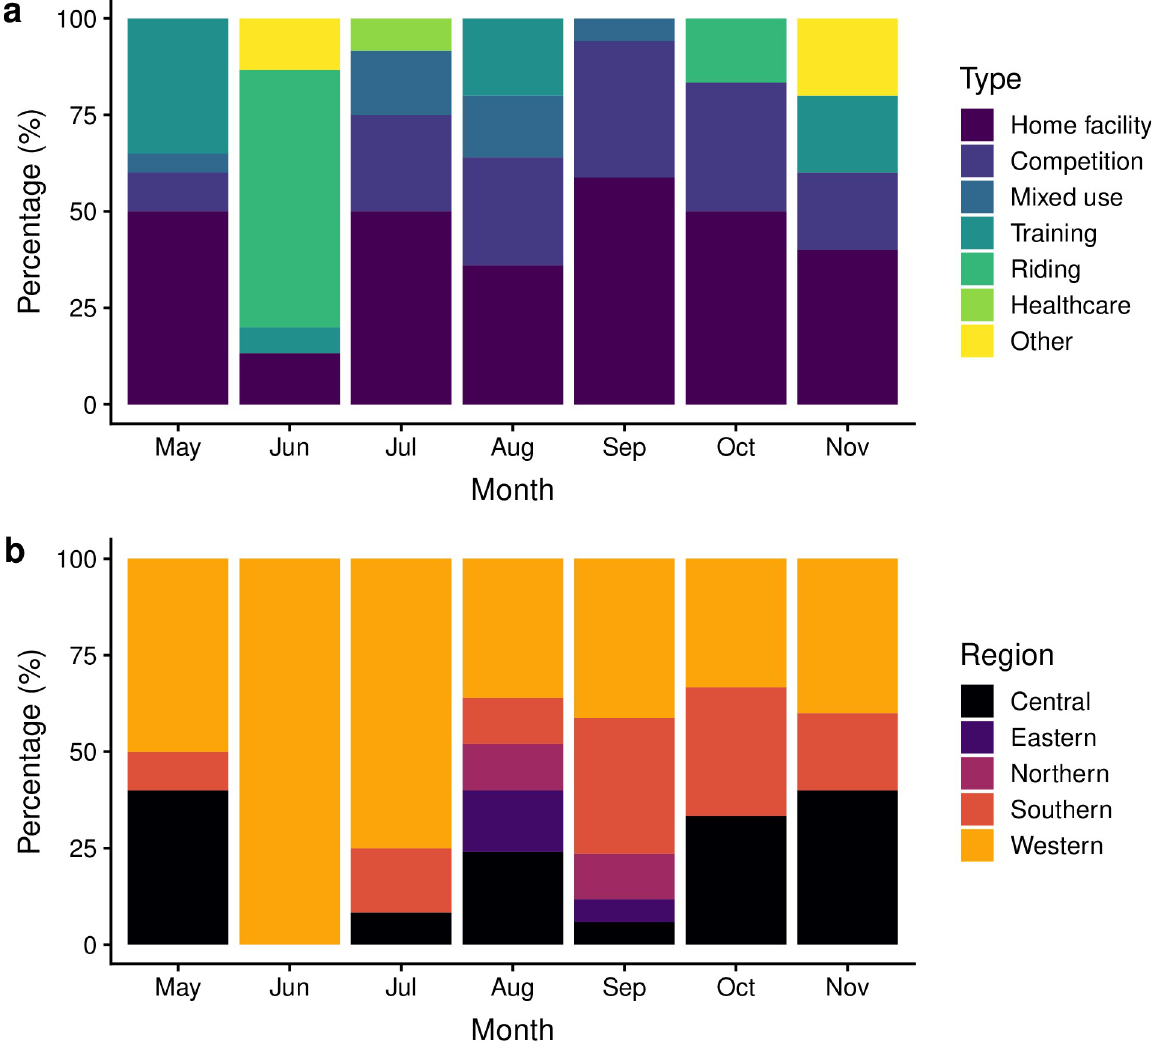
Fig 5. Characteristics of nodes included in the giant strong component (GSC) in each monthly network. Panels represent the (a) location type and (b) region of the